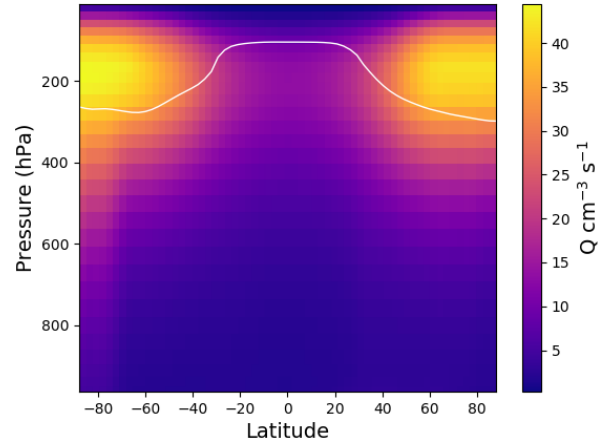
Figure 3. Zonal average yearly mean ion pair production rate, Q , from EMAC for 2008. The white line shows the tropopause.